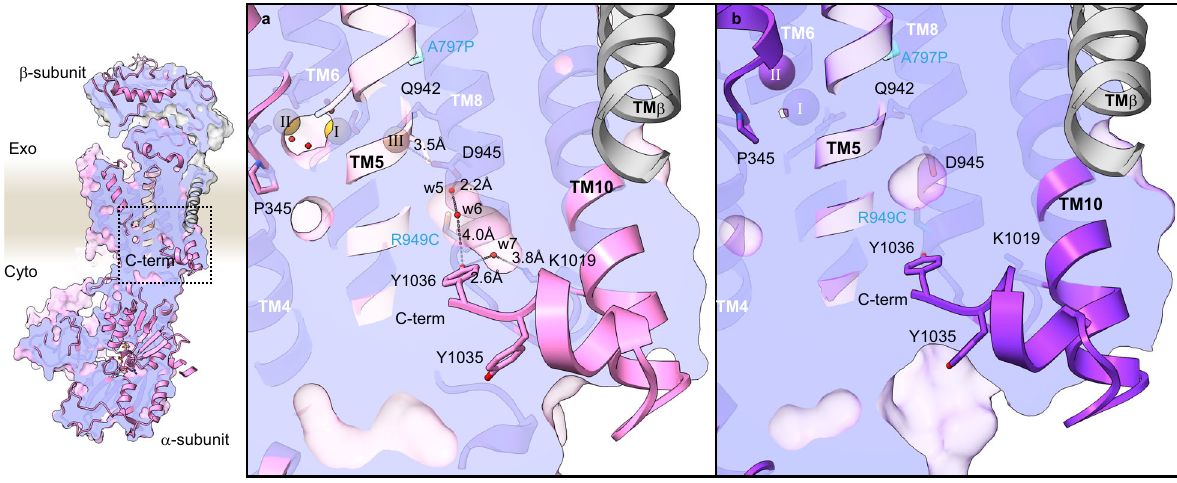
Fig. 10 | C-terminal water- fi lled cavity. Clipped membrane slice of C-terminal region of SPWC-ngHKA in the 3Na + ·E1-ATP ( a ) and (2K + )E2-P i states ( b ) at the positionindicatedbyablackboxonthezoomed-outviewofthemolecule,viewed from a plane approximately parallel to the membrane, with extracellular side-up.